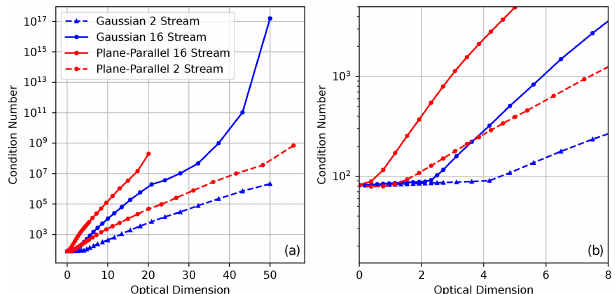
Figure 17. The dependence of the condition number of the approxi- mate Jacobian on the optical dimension which is the vertical optical thickness of plane-parallel homogeneous (red lines) and the optical radius of 3D Gaussian (blue lines) extinction fields. Panel (b) is a magnified version of panel (a) , highlighting the different behaviors at small optical depths. The plane-parallel 16 stream curve stops at maximum optical thickness 20, since, beyond this, it becomes truly ill-posed (condition number tending to